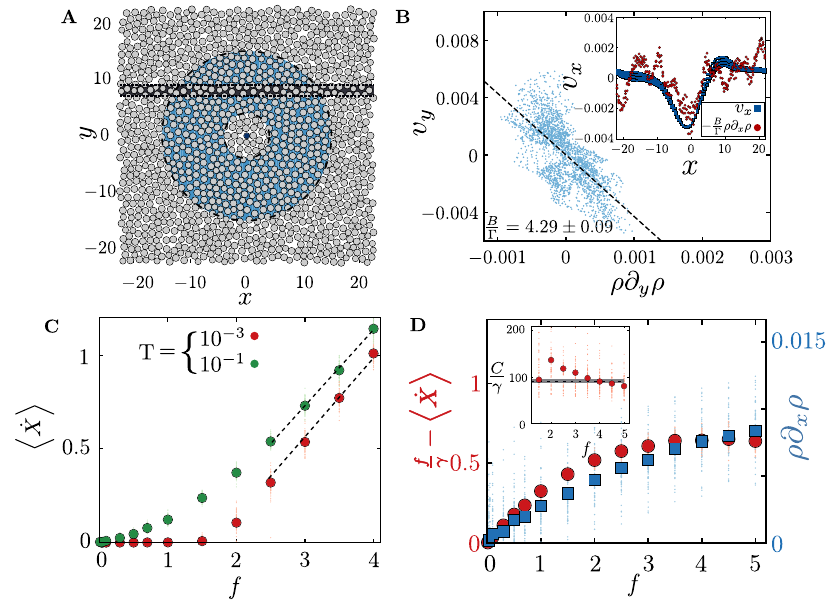
C Mean velocity of the active particle _ X (red and green dots) vs. active force, f